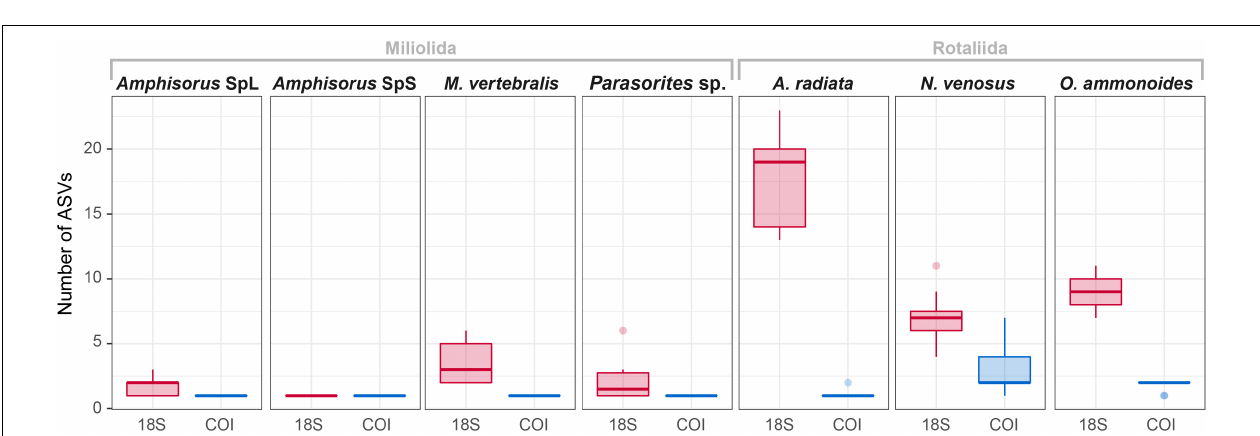
FIGURE 2 | Comparison of the intra- and inter-specimen genetic variability between COI and 18S markers based on patristic distances. The black circles represent the mean distance and the vertical black line the standard deviation from the mean. Statistical Levene’s test (triangles) and Fligner-Killeen test (squares) were performed for each species and each variability level (intra- or inter-specimen). Complete statistical results in Supplementary Table 2 . Significant differences in variance between both markers are indicated with black-filled shapes, whereas not significant results are indicated with white-filled shapes. The absence of boxplot in a facet means that there is no genomic variation (where the total number of ASVs = 1).